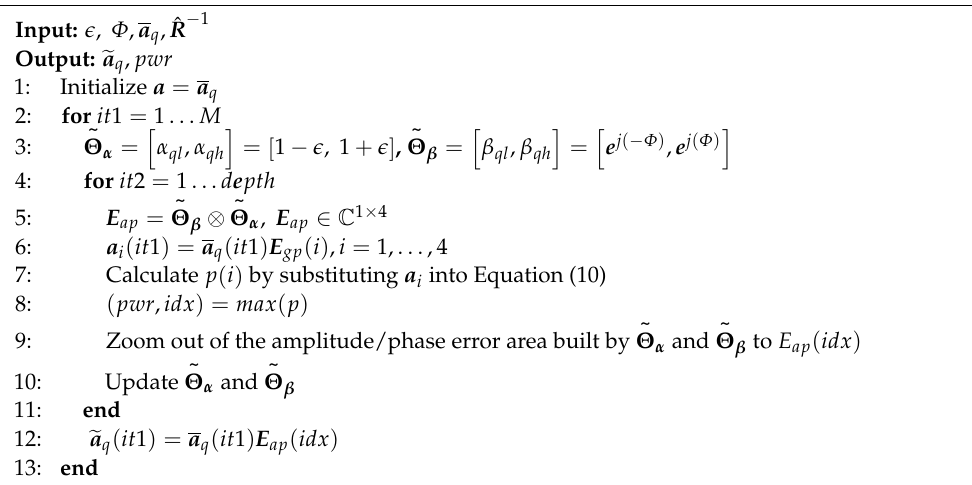
Algorithm 1. Iterative mismatch approximation